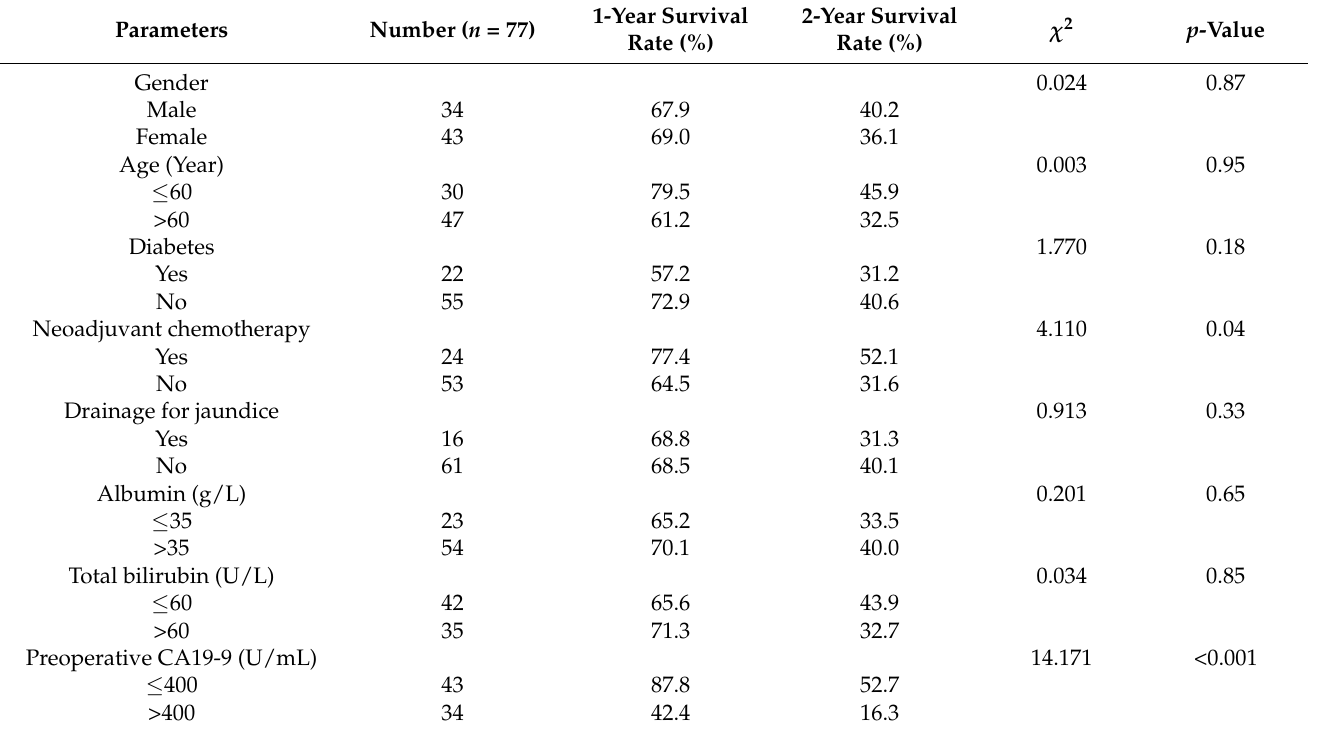
Table 3. Univariate analysis of postoperative long-term survival in patients with